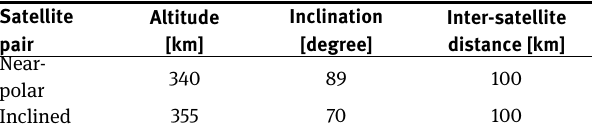
Table 1. Orbit parameters for satellite